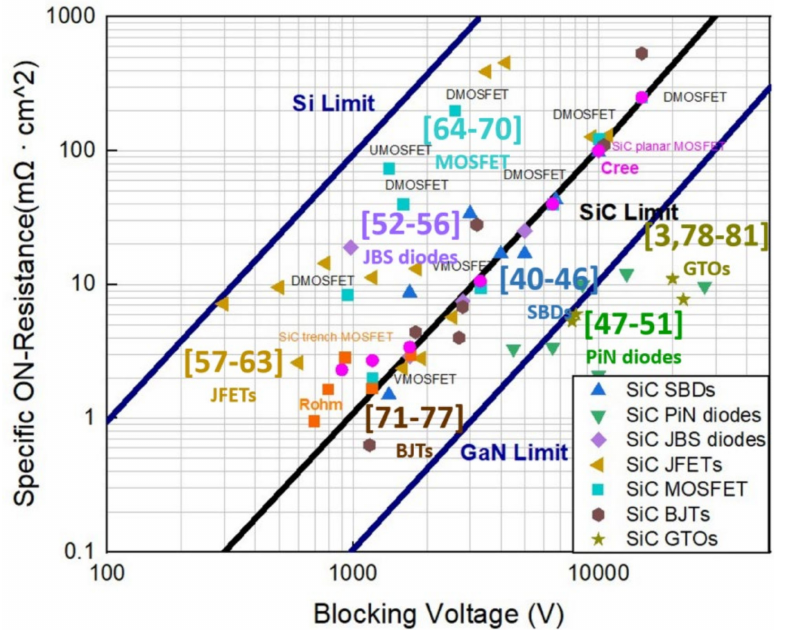
Figure 3. The benchmarking plot on specific on-resistance and breakdown voltage for various SiC power devices